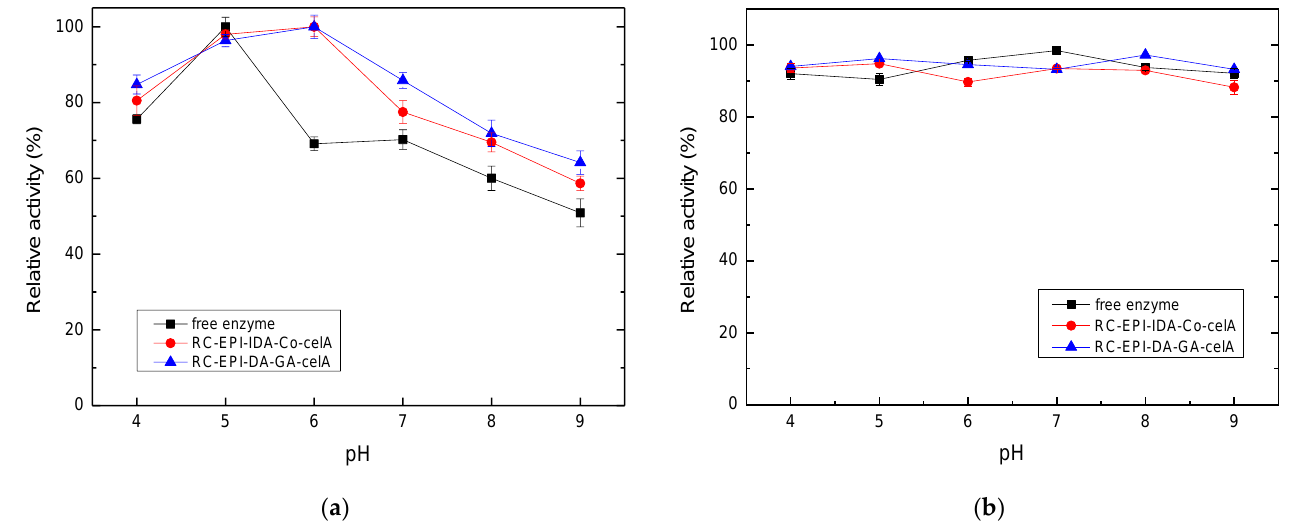
Figure 7. ( a ) Optimum pH and ( b ) pH stability of free and immobilized CelA endoglucanase.